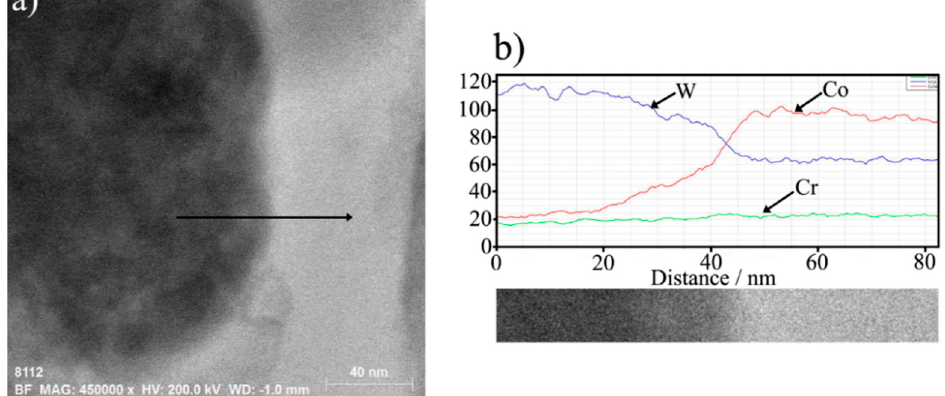
Figure 5. ( a ) High magnification microstructure of the interface between a tungsten carbide particle and the surrounded binder; ( b ) W, Co, Cr-element line scan result of the arrow line in ( a ) and the corresponding enlarged microstructure image. The direction of the arrow means the scanning direction.